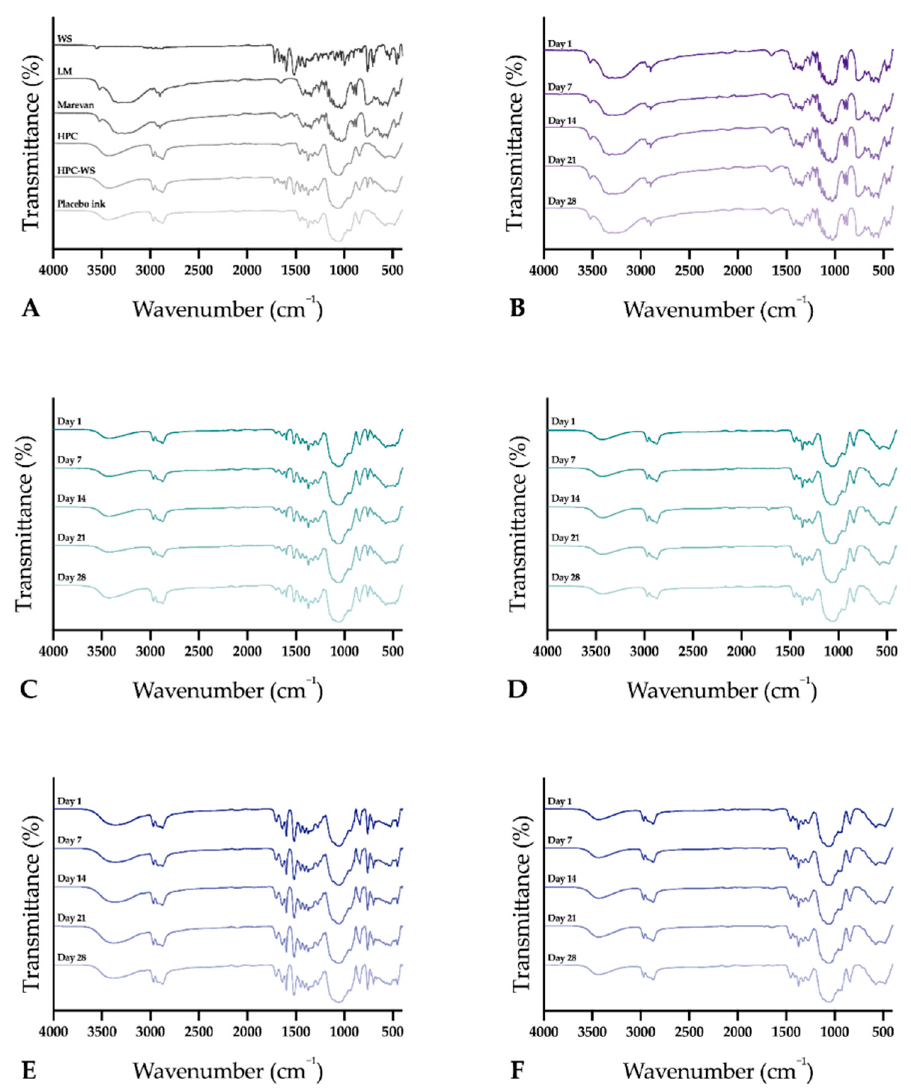
Figure 10. FT-IR spectra for ( A ) raw materials and / or starting materials; ( B ) OPS; ( C ) drug-loaded EXT; ( D ) placebo EXT ODF; ( E ) drug-loaded IJP ODF; and ( F ) placebo IJP ODF. The graphs present